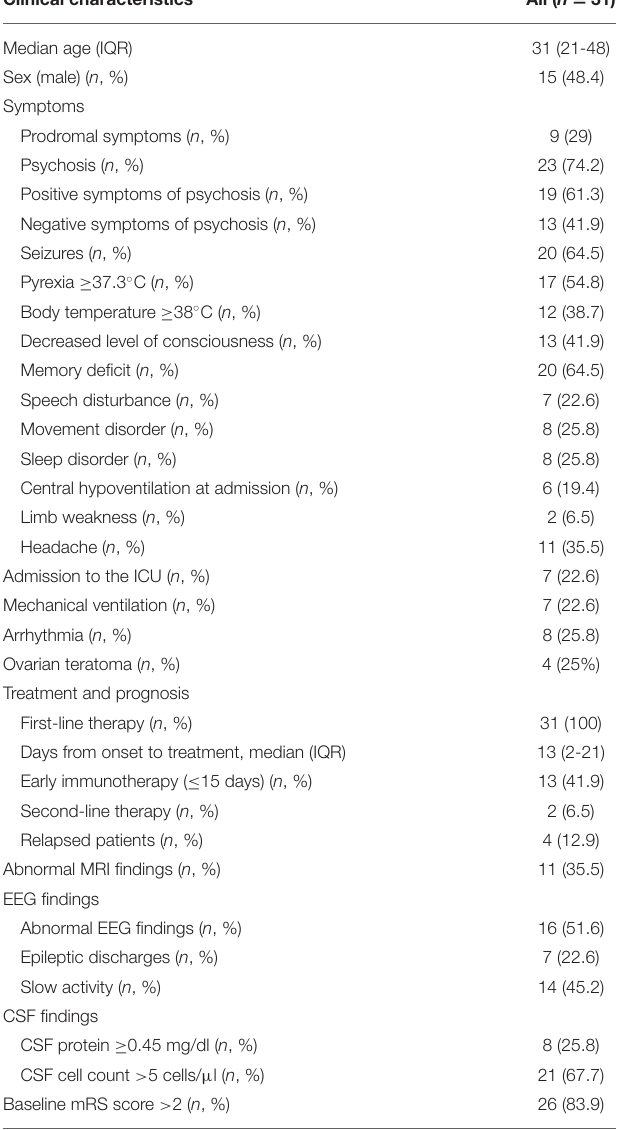
TABLE 2 | Univariate logistic regression analysis of risk factors predicting the need for mechanical ventilation. Clinical